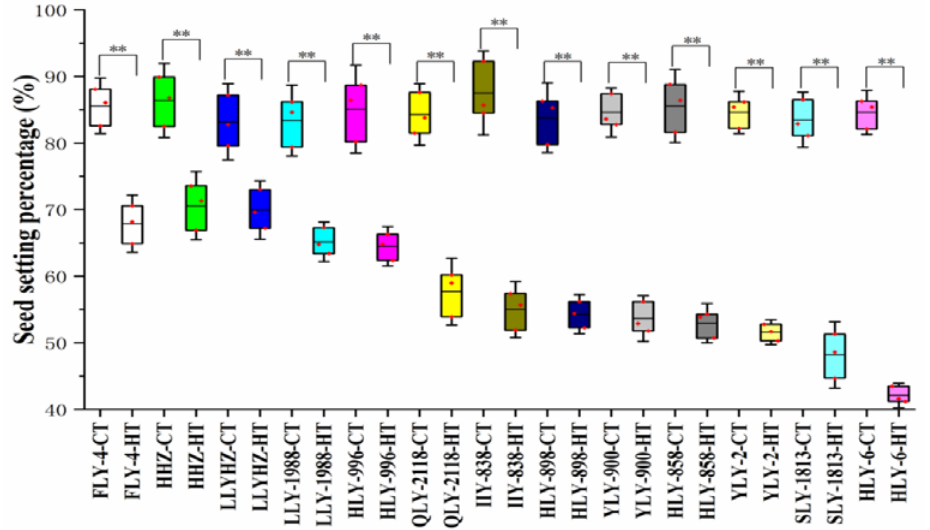
Figure 4. Seed setting percentage of different varieties under high-temperature and normal-temperature treatment. NT: Normal-temperature treatment. HT: High-temperature treatment. Error bars are the standard deviation (±SD) of three biological replicates. ** p < 0.01 by Student’s t -test.